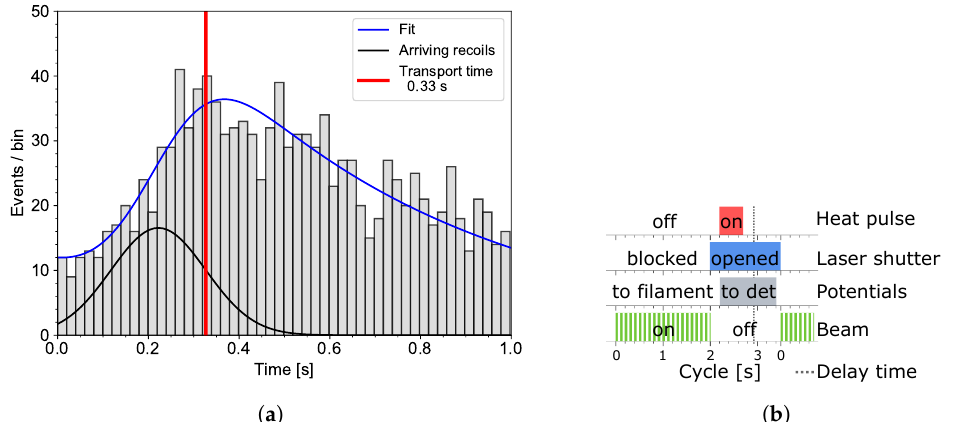
Figure 4. ( a ) Time structure of decay signals from incoming nuclei produced by 5ms pulses from the accelerator with a repetition rate of 1Hz. The incoming ions were directly transported to the detector. The transport time marked in red is determined as the time needed for 84.13% of the ions within the assumed Gaussian time distribution (black) to arrive on the detector. For more details, see text. ( b ) New, short RADRIS cycle for resonance ionization spectroscopy of 154 Yb. The overall cycle, as well as the beam break and the delay between beam stop and potential switch were generously shortened. The delay time between stopping of the accelerator beam and arrival of laser ions is marked in the cycle and needs to be considered for further decay